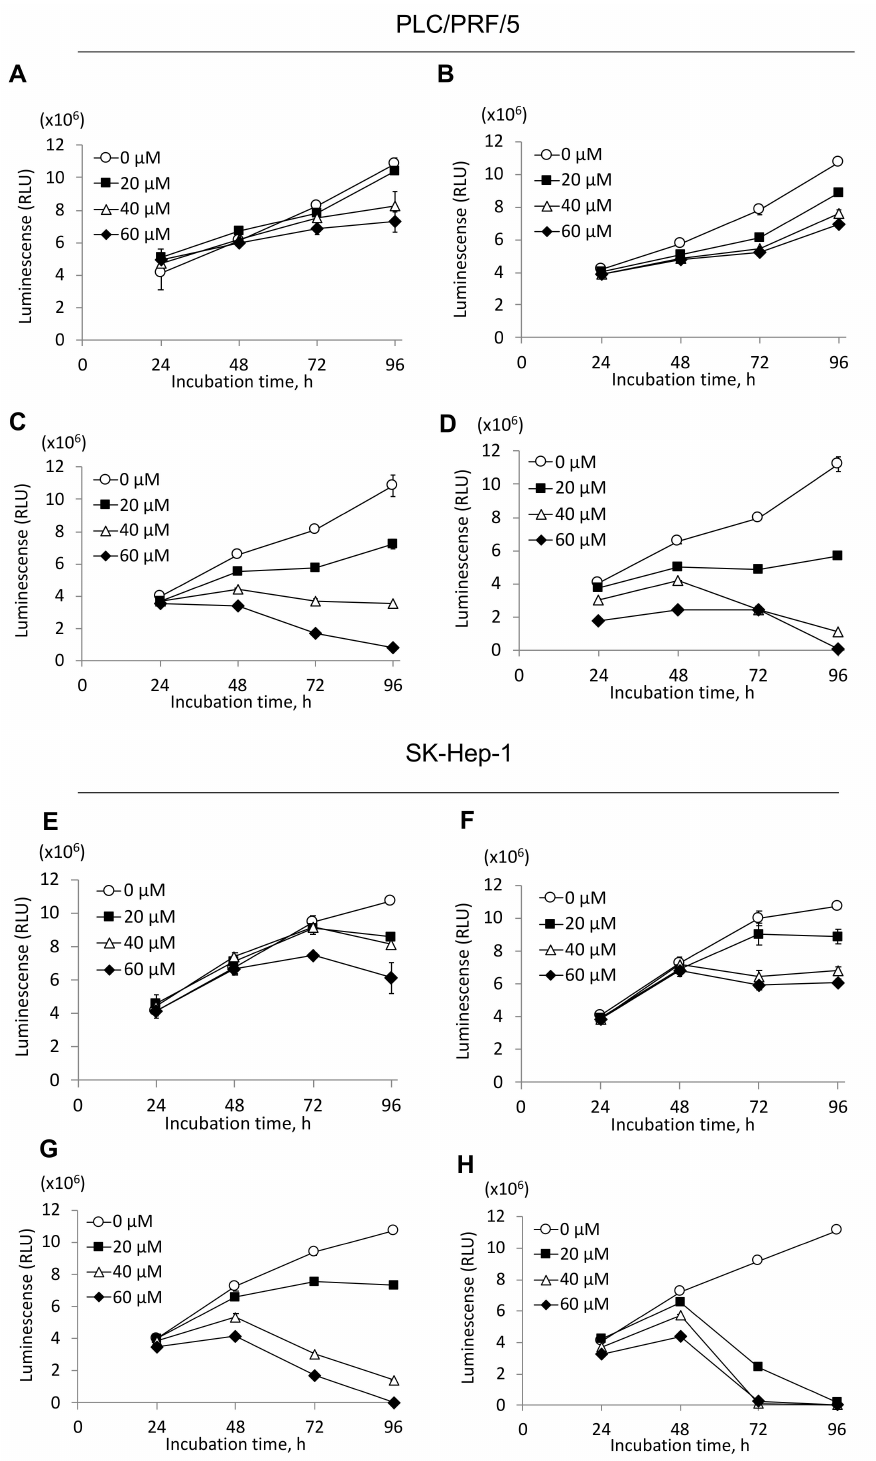
Figure 6. Inhibitory effects of MKH-ester prodrugs and MK-4 on DCP-positive and DCP-negative HCC cell proliferation. MKH-ester prodrugs or MK-4 treatment of PLC/PRF/5 ( A – D ) and SK-Hep-1 ( E – H ) cell lines. ( A , E ), MK-4; ( B , F ), MKH-ACT; ( C , G ), MKH-DMG; ( D , H ), MKH-SUC. PLC/PRF/5 cells are DCP-positive, and SK-Hep-1 cells are DCP-negative. Symbols: , 0 µ M; (cid:4) , 20 µ M; (cid:52) , 40 µ M; (cid:35) , 60 µ M after MKH-ester prodrug or MK-4 treatment. Error bars indicate means ± SDs ( n =